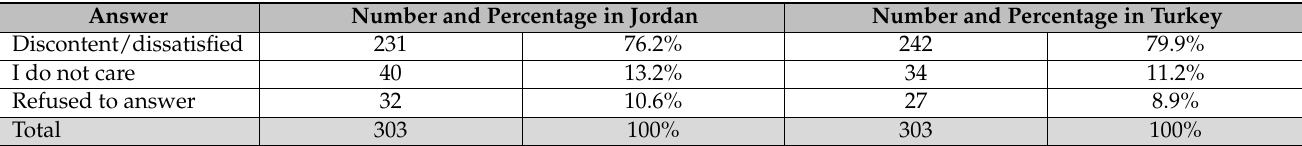
Table 5. The Participants Feeling when they see Syrian Refugees’ Abuse in News, Photos and Comments in Social Media in General.